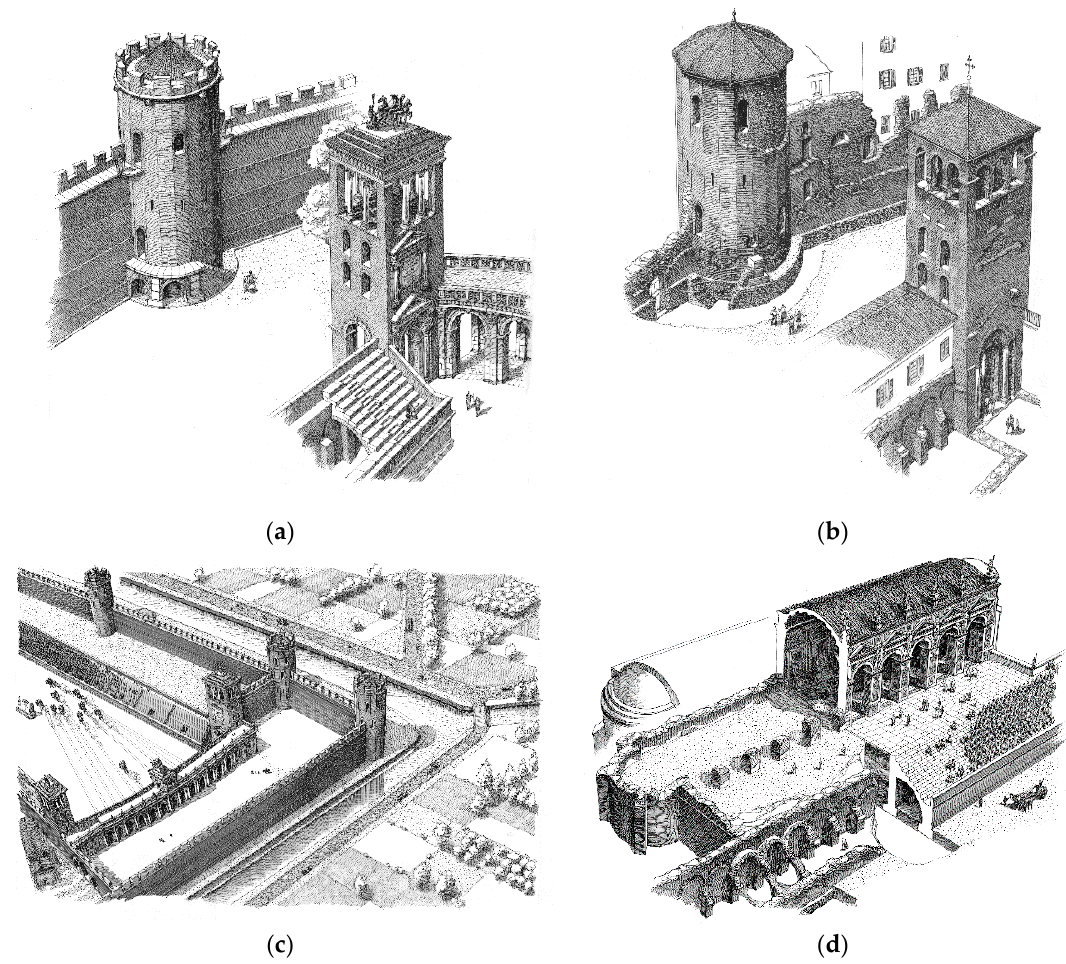
Figure 13. Drawing by Corni (courtesy of the Directorate of the Archaeological Museum) about the reconstruction of some parts of the Circus: ( a ) the tower of the city walls facing the tower of the carceres as they were during the late roman time; ( b ) as they look now inside the garden of the archaeological museum; ( c ) the view from the starting point of the races; ( d ) the hypothesis of the dais where the emperor and his entourage watched the races.